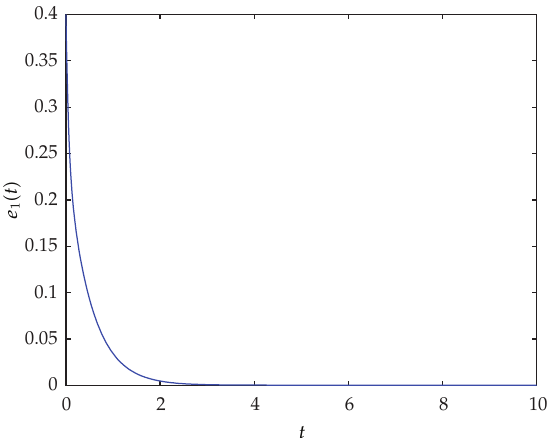
Figure 3: Time evolution of the lag synchronization errors e 1 (cid:4) t (cid:5) .